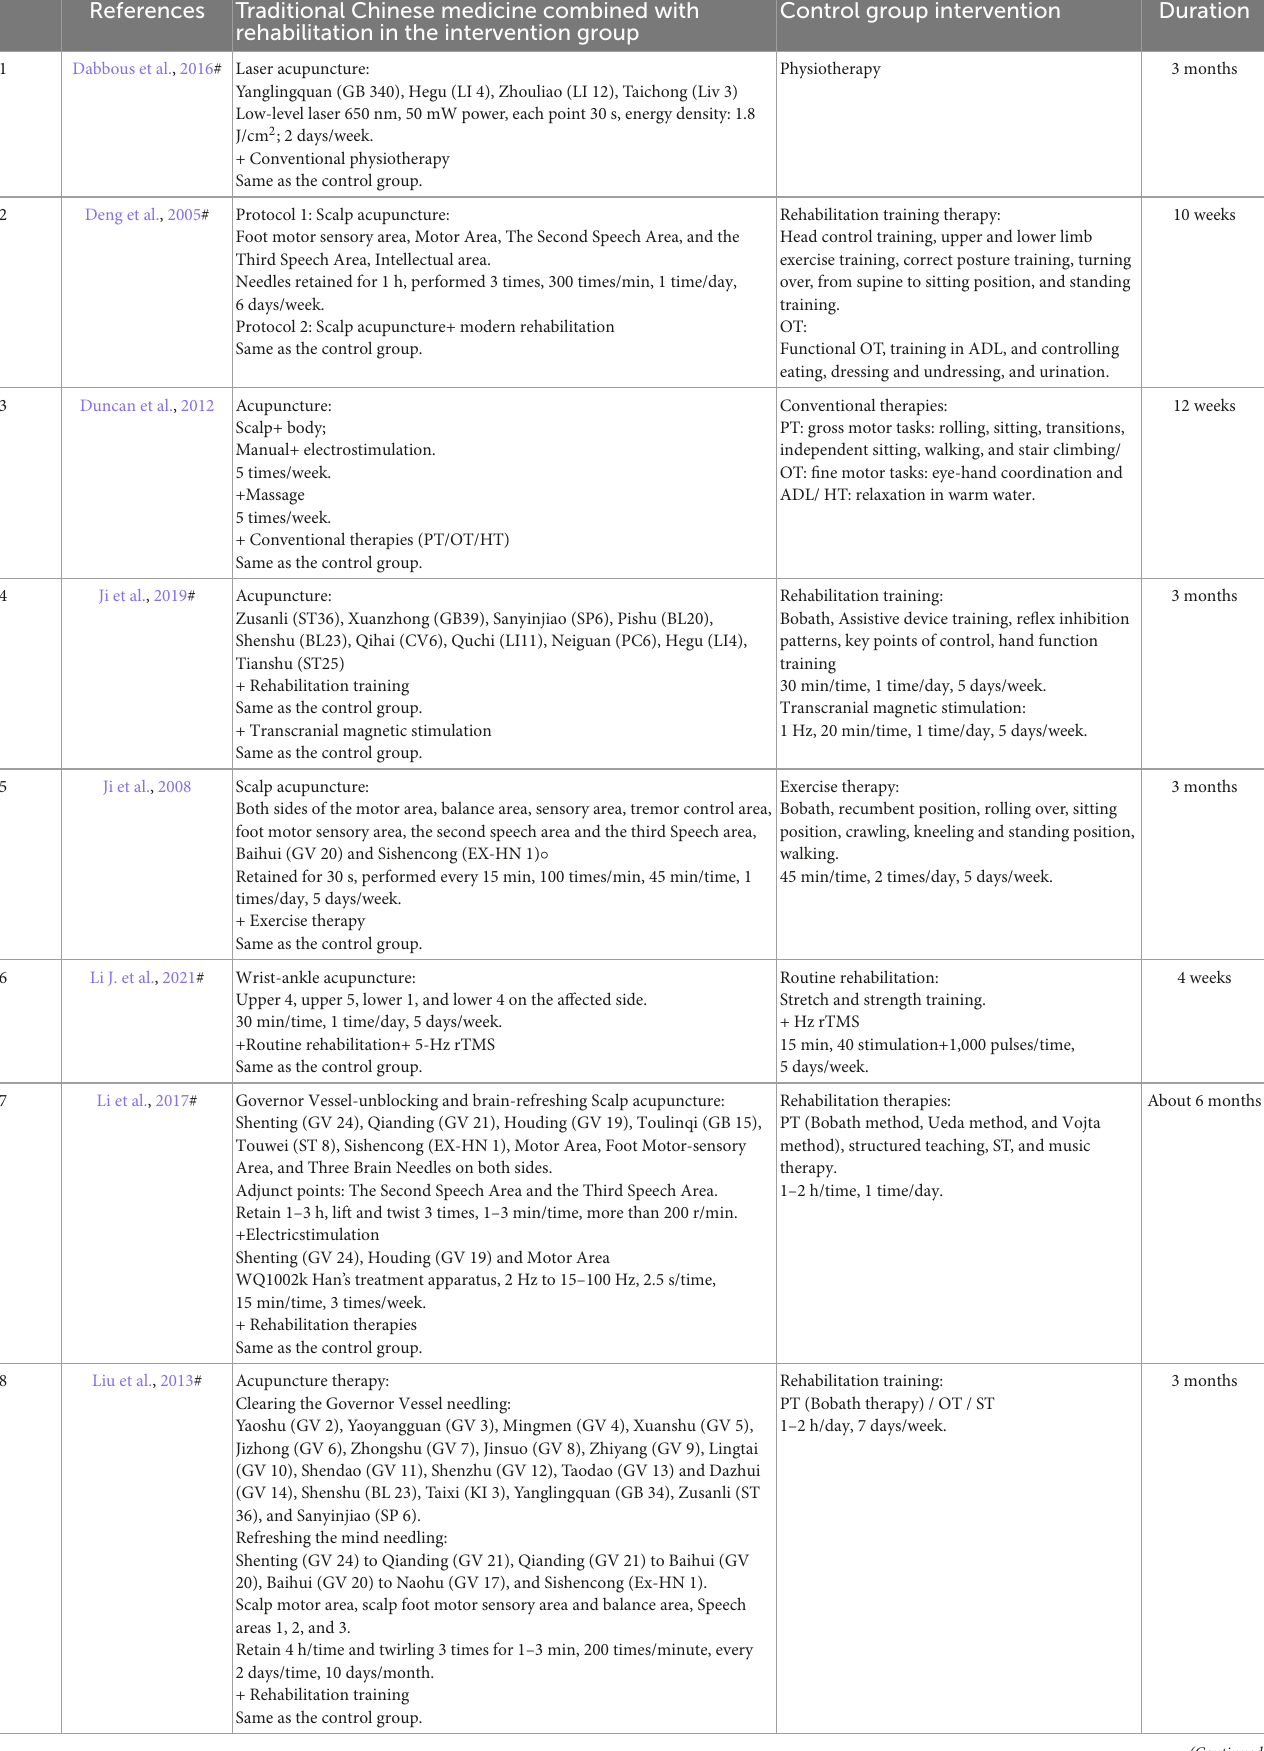
TABLE 2 Traditional Chinese medicine combined with rehabilitation and control interventions in the included trials.